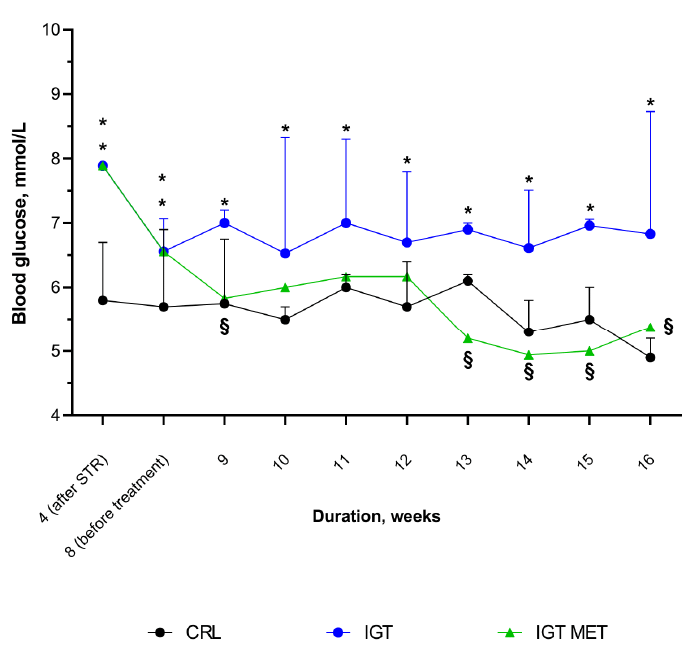
Figure 4. Dynamics of blood glucose level in rats from different groups. Notes: Results are presented as median (25%; 75%). C-CRL(control group), IGT—impaired glucose tolerance group, IGT MET— impaired glucose tolerance + metformin group. * p < 0.05, in comparison with CRL group, § p < 0.05, in comparison with “IGT”